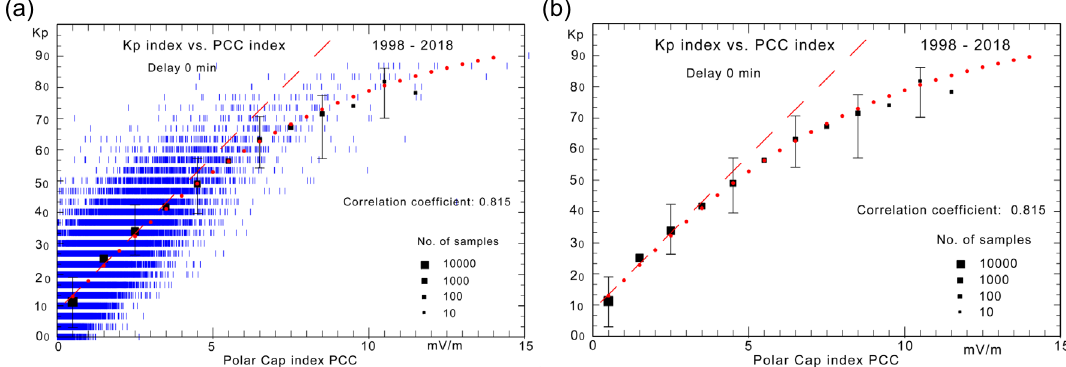
Fig. 7. Relations between Kp and the polar cap PCC indices. (a) Display of all K P -PCC samples. (b) Display without samples. The black squares present averages of Kp index values and number of 15-min PCC samples for each unit of PCC while the error bars indicate standard deviation. The dashed line indicates a linear relation while the small red dots indicate a